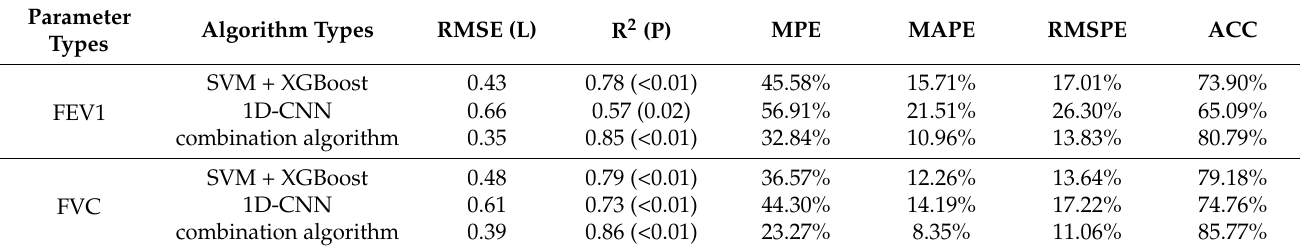
Table 7. Results of the different